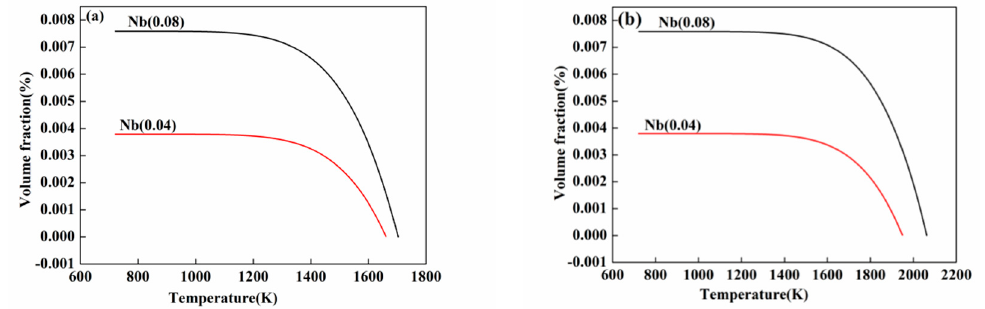
Figure 8. Volume fraction of TWIP steel with different Nb content at any temperature: ( a ) is the result of statistical analysis and ( b ) is the result of phase analysis.